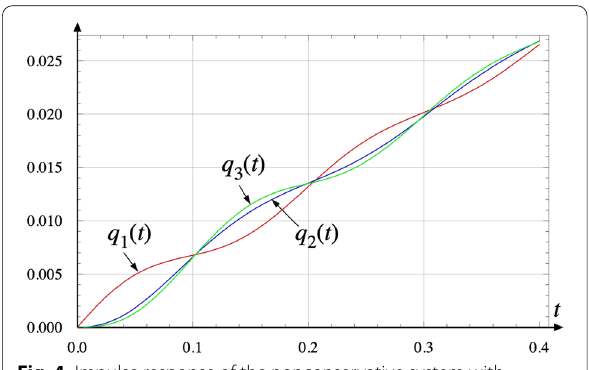
Fig. 4 Impulse response of the nonconservative system with damping. The response q 1 ( t ) , q 2 ( t ) , and q 3 ( t ) are